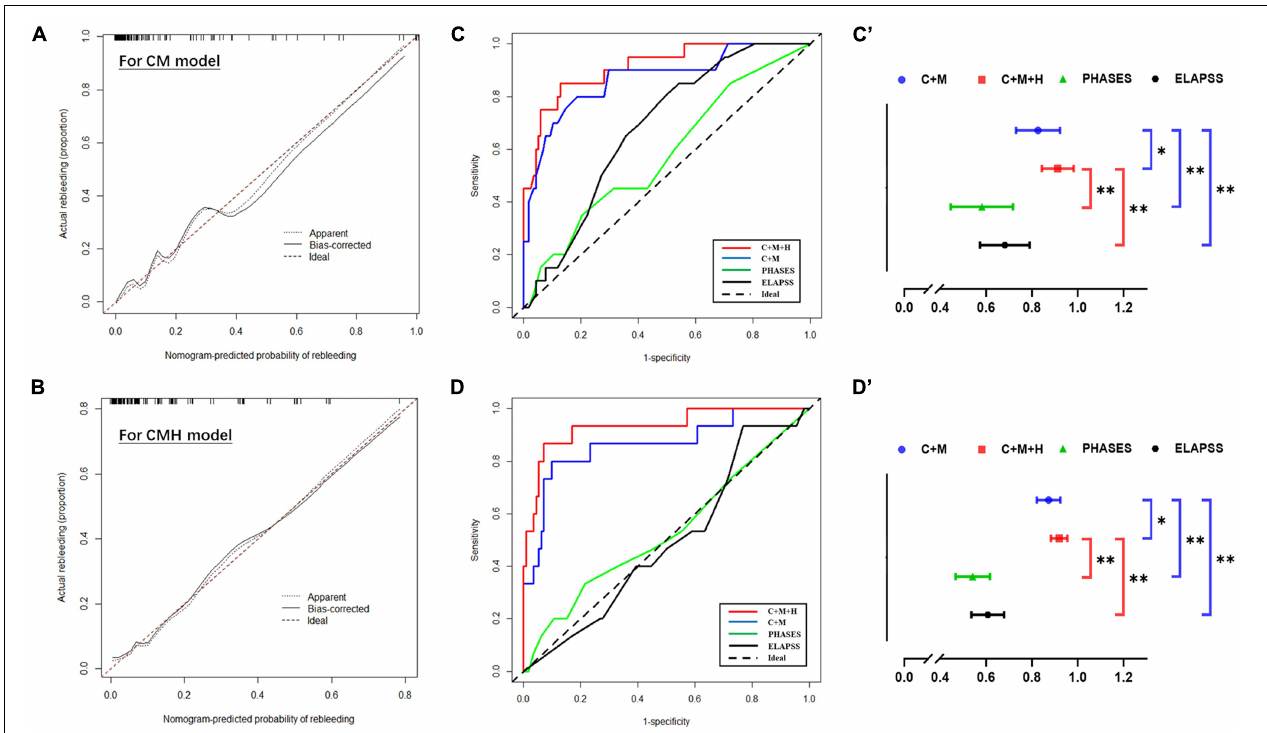
FIGURE 5 | The predictive accuracy of models for rebleeding. (A,B) The calibration plots display a substantial agreement between the prediction by each nomogram and the actual observation, in the risk of rebleeding before the surgery. (C,C’,D,D’) The ROC analyses based on the primary cohort and validation cohort showed a good predicting accuracy of two nomogram models, whereas a poor predicting accuracy of PHASES and ELAPSS score was found. ∗ P < 0.05; ∗∗ P < 0.01.